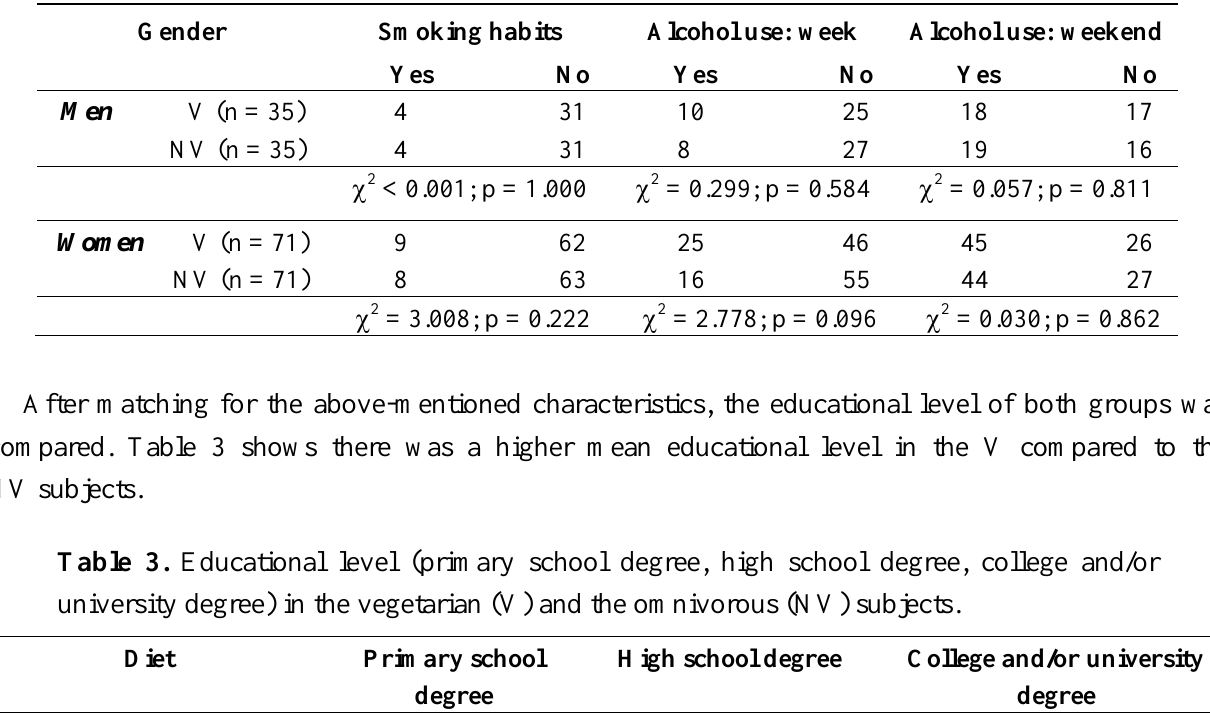
Table 2. Differences by gender in smoking habits and alcohol use during the week and at the weekend between the vegetarian (V) and the omnivorous (NV) subjects.